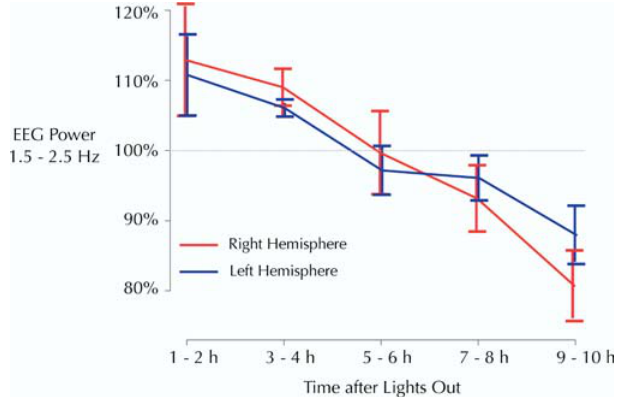
Figure 5. Time Course of EEG Power Density in the 1.5- to 2.5-Hz Band in SWS This figure shows the time course of EEG power density in the 1.5- to 2.5-Hz band in SWS during the dark phase for the left (blue) and right (red) hemisphere in nonmigrating sparrows. Curves represent mean 2-h values with standard error of the mean ( n = 5). The EEG power density in the 1.5- to 2.5-Hz band of each 2-h interval is expressed as a percentage of the average EEG power in the 1.5- to 2.5-Hz band over all SWS epochs (dashed line = 100% of average 1.5- to 2.5-Hz power). The last 2-h interval is excluded since not all birds exhibited SWS during this time. A two-way, repeated measures ANOVA, with ‘‘ hemisphere ’’ and ‘‘ 2-h intervals ’’ as factors, revealed a significant effect of the 2-h interval ( F = 5.60, p , 0.05 with the Greenhouse– Geisser correction); neither an effect of hemisphere, nor an interaction between hemisphere and interval reached statistical significance ( p .